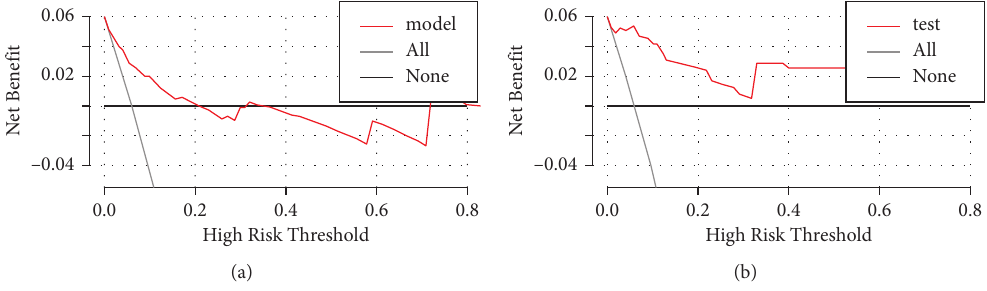
Figure 4: Decision curve analysis (DCA) for the risk model for the training set (a) and the testing set